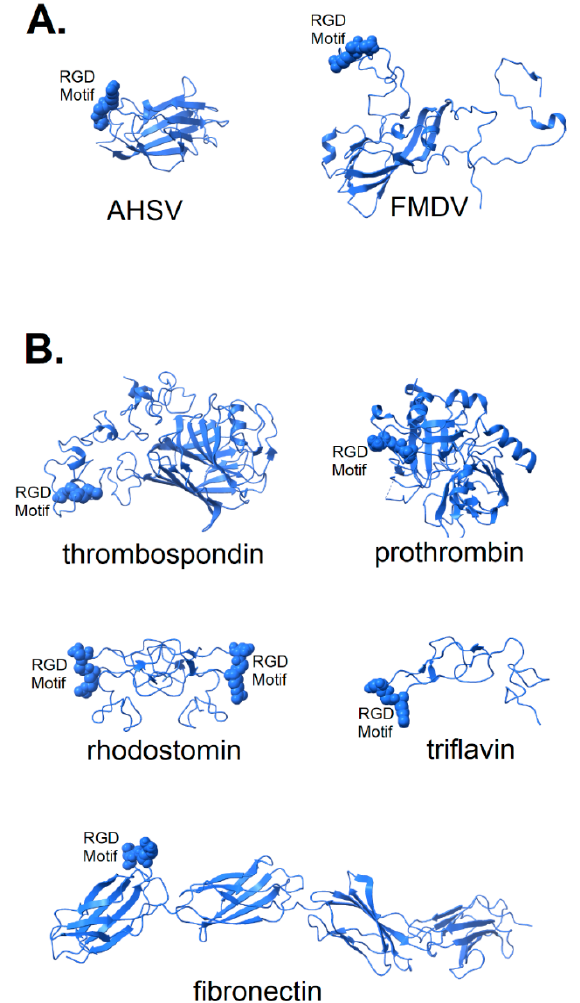
Figure 2. Structure of known integrin-binding proteins: ( A ) Virion proteins known to bind integrins through an RGD motif (shown in space-fill) include (right) foot and mouth disease virus capsid protein (5neu—this RGD motif is highly flexible prior to integrin-binding, but structurally stabilized when bound to integrin—image is from a co-crystal of the capsid protein and integrin with integrin structure removed to make visible the RGD domain); (left) African horse sickness virus (1ahs—top domain of capsid protein VP7). ( B ) Other proteins known to bind integrin through an RGD motif: thrombospondin (1ux6); prothrombin (3u69); rhodostomin (4rqg) and triflavin (1j2l) are disintegrins, small toxins from snake venom with high affinity to integrins; and fibronectin (1fnf—domains 6–10)—an extracellular matrix protein with an integrin-binding RGD motif in its 10th domain.